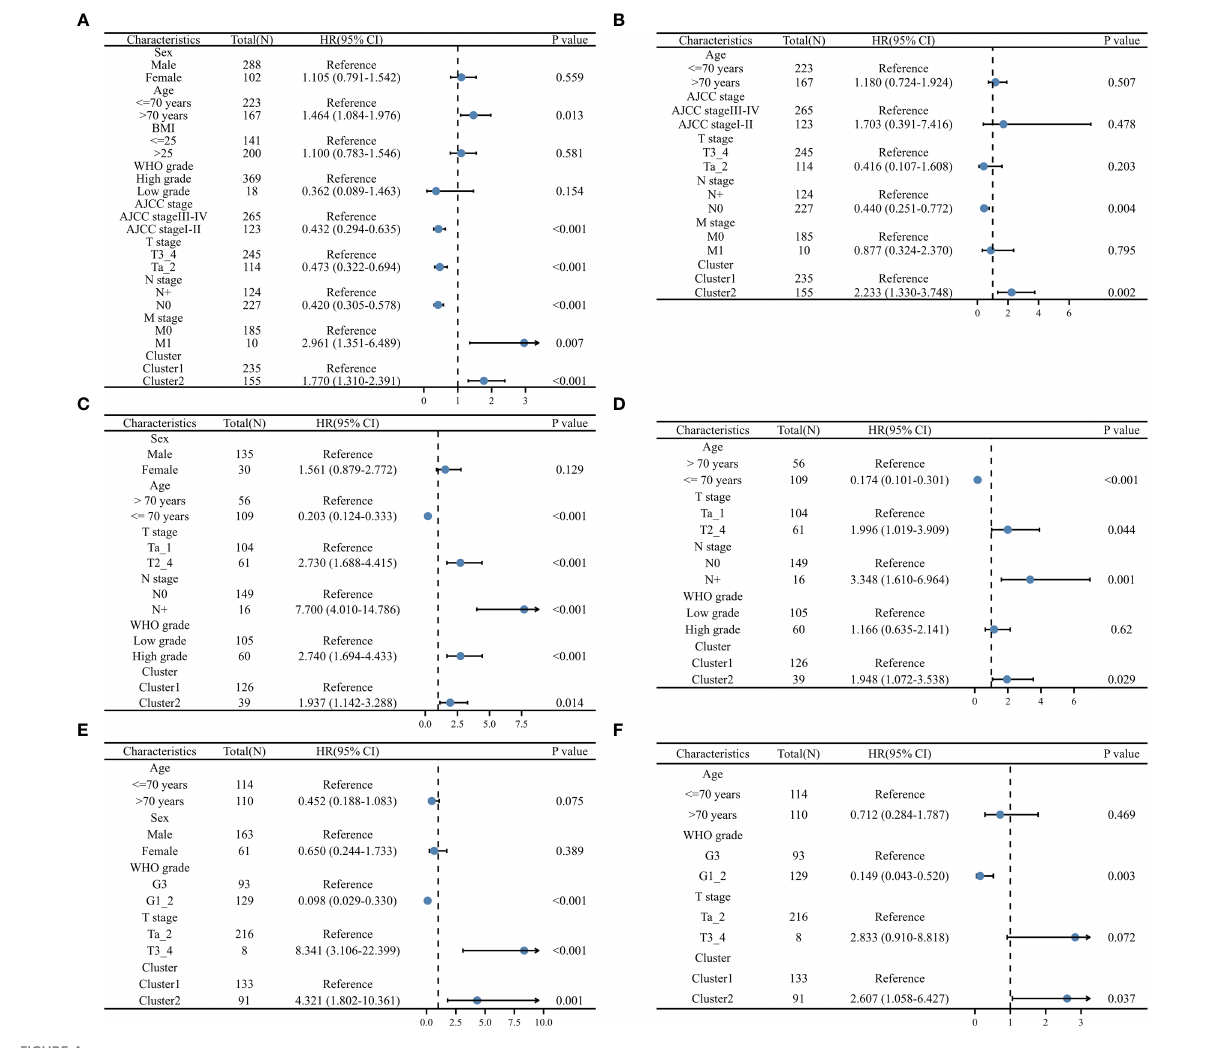
FIGURE 4 Validation of the independent prognostic value of the cluster: univariable (A) and multivariable (B) Cox regression model in TCGA dataset, univariable (C) and multivariable (D) Cox regression model in GSE13507 dataset, univariable (E) and multivariable (F) Cox regression model in GSE32984 dataset, N, lymph node metastasis; M, distant metastasis; WHO, World Health